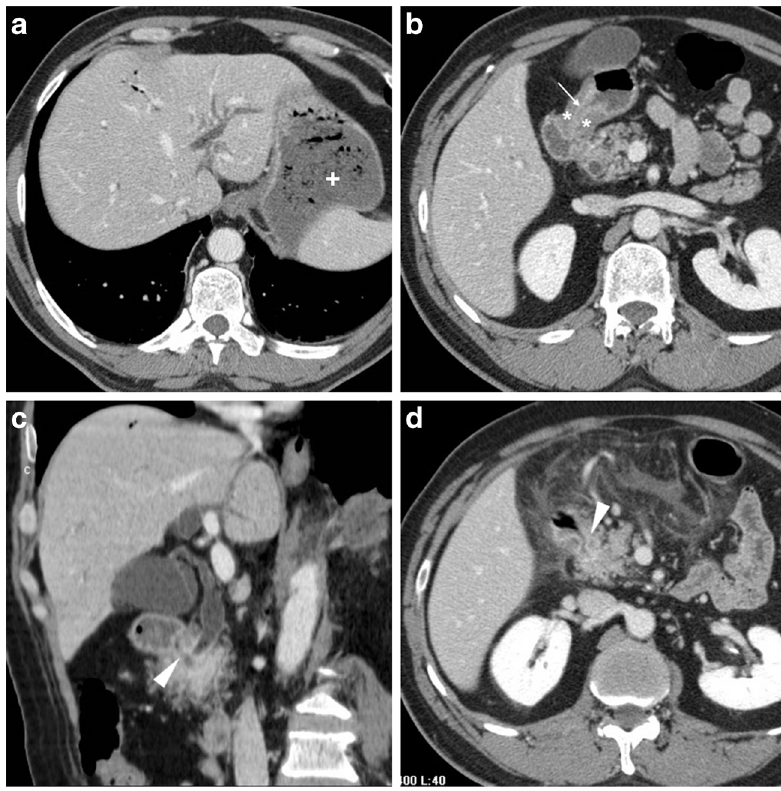
suggesting fistulisation (arrowhead in c ) was identifiable between proximal duodenum and distal choledochus. Endoscopy showed duodenal bulb deformation from chronic PUD without active ulcers, and endoscopic retrograde cholangiopancreatography was unsuccessful. During a bout of acute pancreatitis, repeated CT ( d ) confirmed choledocho-duodenal fistula (arrowhead). Prolonged medical therapy ultimately allowed resolution of symptoms [Adapted with permission from ref. no